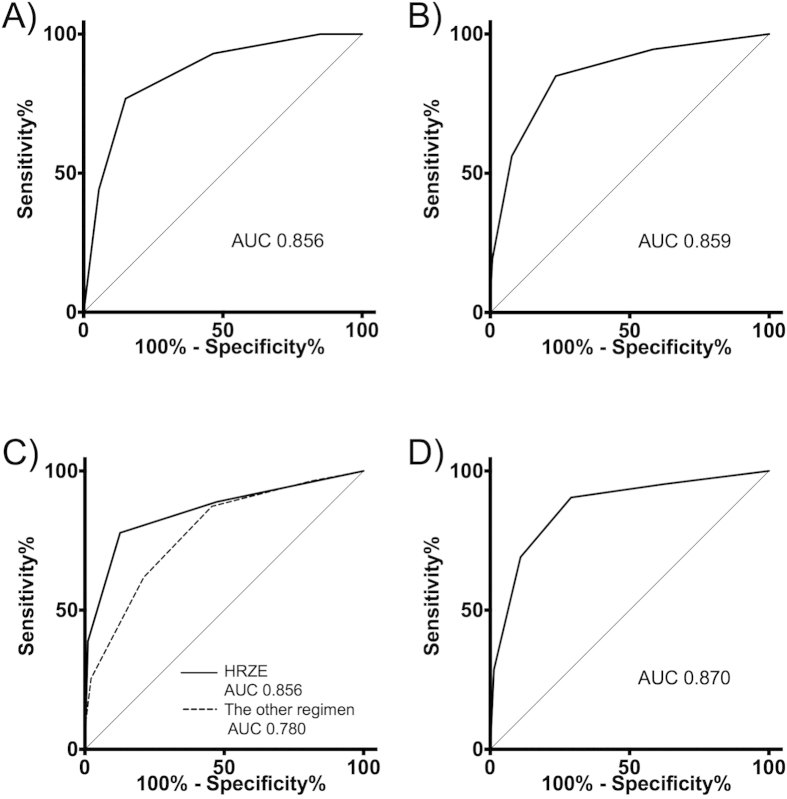
Receiver operating characteristic curves.(A) All-case analysis by total A-DROP score for in-hospital death. (B) All-case analysis by scoring excluding the low blood pressure for in-hospital death. (C) Subgroup analysis based on treatment regimen by total A-DROP score for in-hospital death. (D) All-case analysis by total A-DROP score for 28-day death.